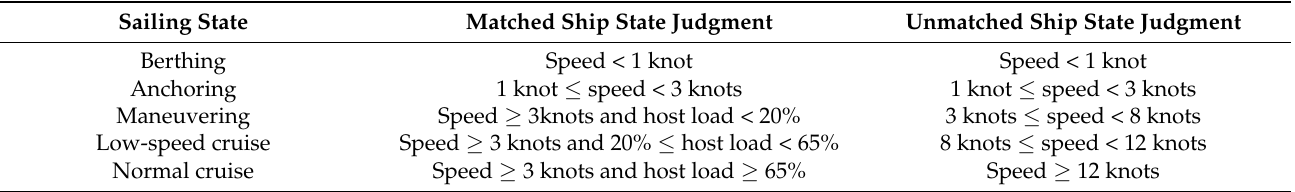
Table 5. Division of sailing state.